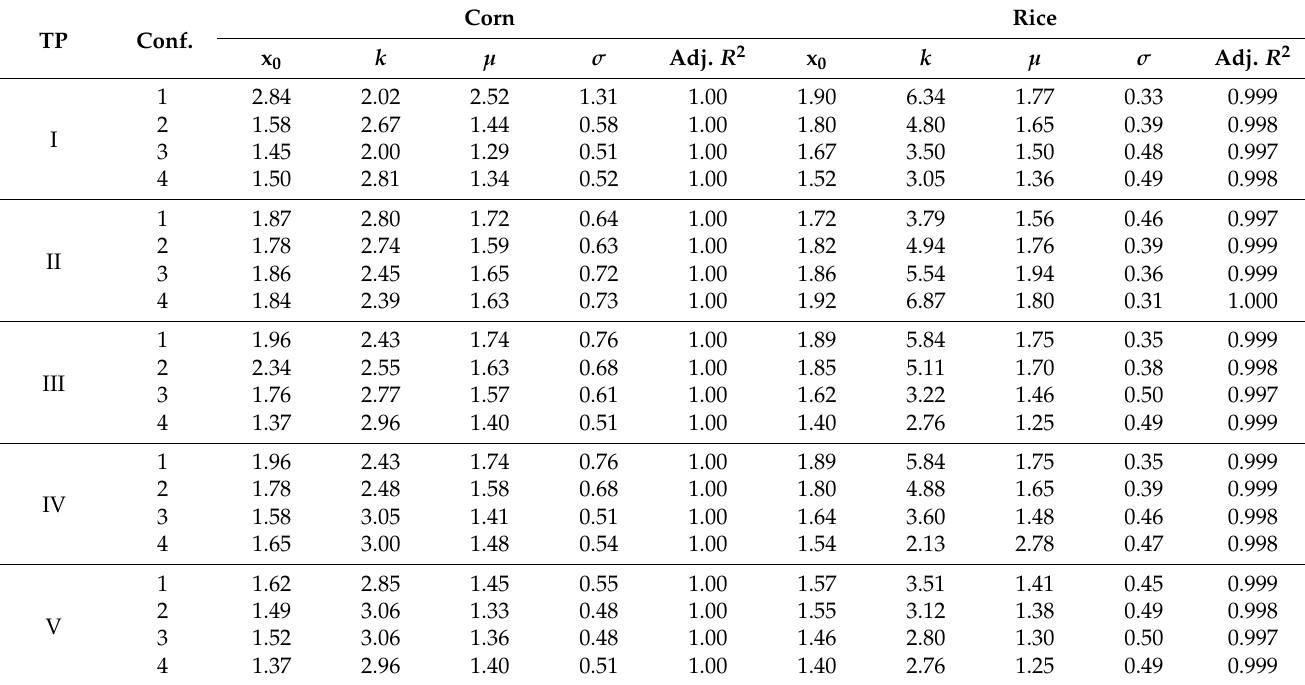
Table 4. The coefficients of the obtained RRSB distributions for the tested configurations of disc angular velocity